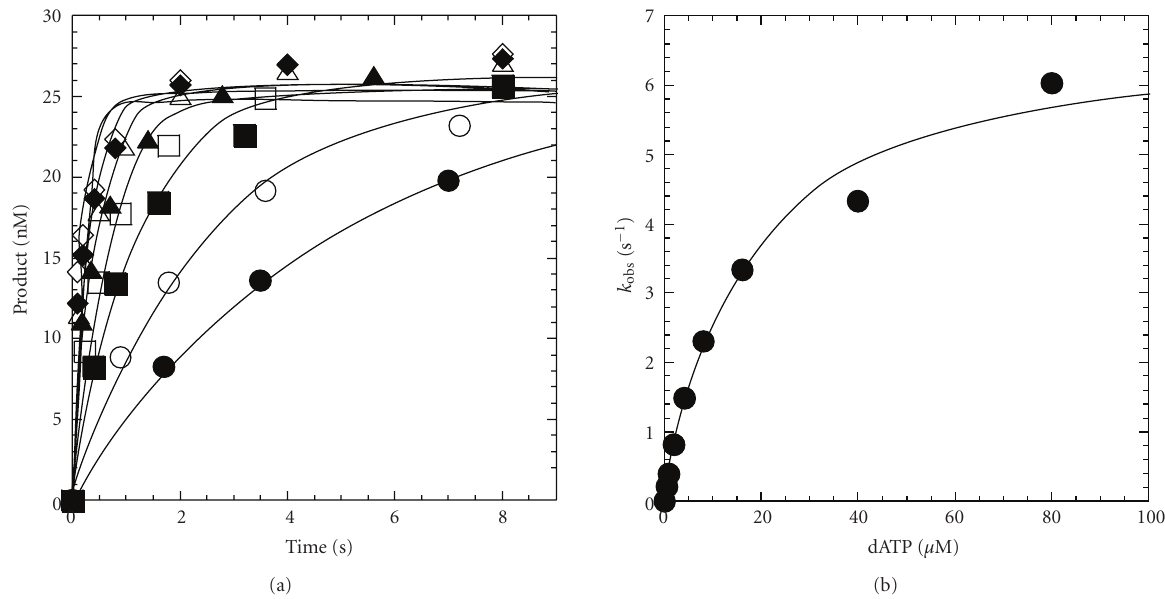
Figure 3: Concentration dependence on the pre-steady-state rate constant of nucleotide incorporation catalyzed by truncated yPol η . (a) A preincubated solution of truncated yPol η (150 nM) and 5 (cid:2) -[ 32 P]-labeled D-7 DNA (30nM) was mixed with dATP · Mg 2+ (0.4 μ M, (cid:2) ; 0.8 μ M, (cid:3) ; 2 μ M, (cid:2) ; 4 μ M, (cid:3) ; 8 μ M, (cid:4) ; 16 μ M, (cid:7) ; 40 μ M, (cid:5) ; 80 μ M, ♦ ) and quenched with EDTA at various time intervals. The solid lines are the